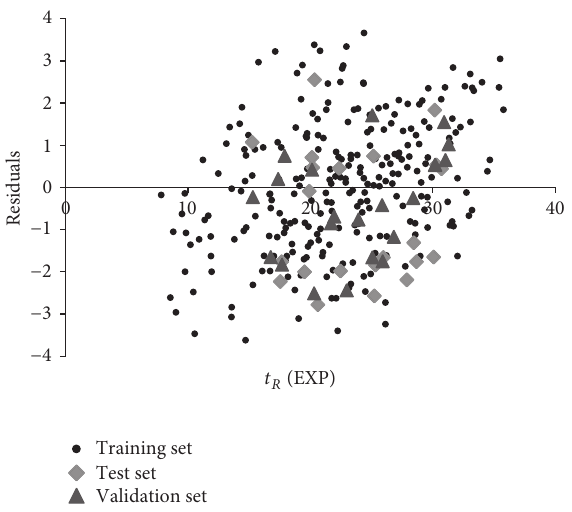
F 5: Plot of the residuals versus the experimental values of for training, test and validation